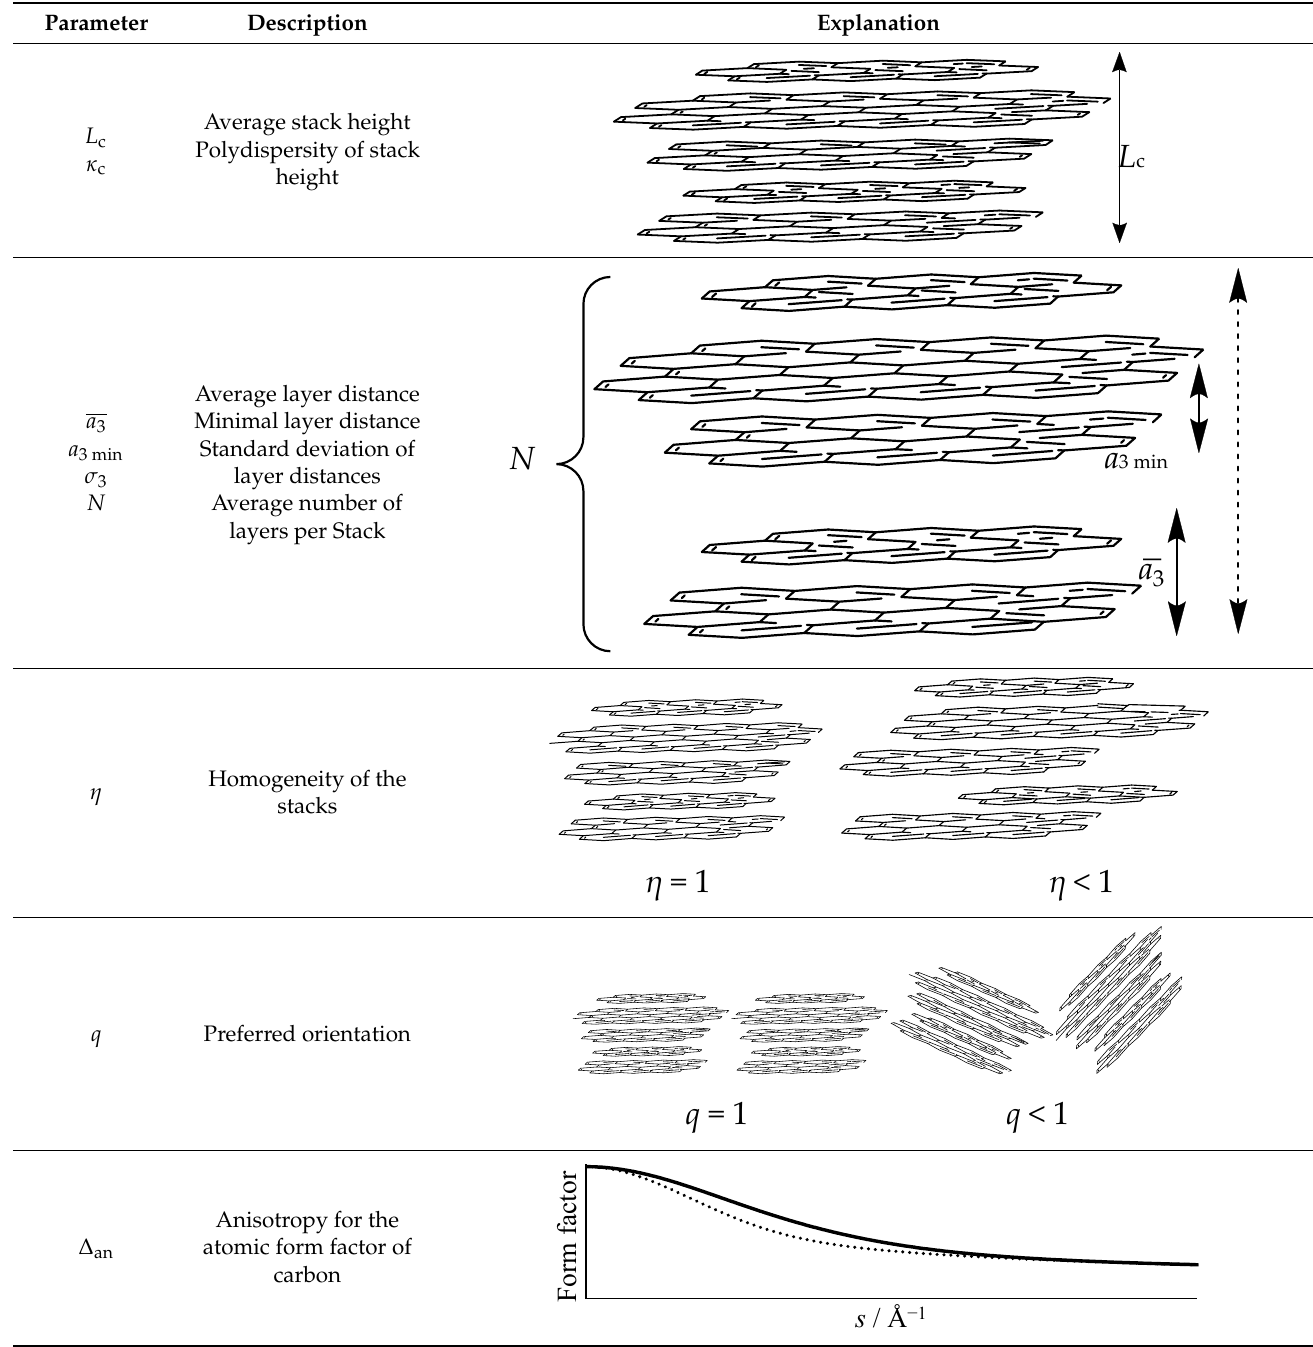
form factor of carbon ( ∆ an ) can be refined but have in most cases only a small influence on the analysis. The preferred orientation parameter ( q ) might also be refined, it also depends on the experimental setup, Table 2. Table 2. Microstructural parameters describing the graphene stacking (interlayer scattering I inter ). L c , κ c Table 2. Microstructural parameters describing the graphene stacking (interlayer scattering I inter ). Table 2. Microstructural parameters describing the graphene stacking (interlayer scattering I inter ). and N are mathematically dependent on each other and calculated from a gamma distribution n ( N ). N L c , κ c and N are mathematically dependent on each other and calculated from a gamma distribution Table 2. Microstructural parameters describing the graphene stacking (interlayer scattering I inter ). Table 2. Microstructural parameters describing the graphene stacking (interlayer scattering I inter ). Table 2. Microstructural parameters describing the graphene stacking (interlayer scattering I inter ). L c , κ c and N are mathematically dependent on each other and calculated from a gamma distribution n ( N ). N being the number of layers per stack, with the parameters μ and β [44] and is also dependent L c , κ c and N are mathematically dependent on each other and calculated from a gamma distribution being the number of layers per stack, with the parameters µ and β [44] and is also dependent on a 3 . L c , κ c and N are mathematically dependent on each other and calculated from a gamma distribution L c , κ c and N are mathematically dependent on each other and calculated from a gamma distribution n ( N ). N being the number of layers per stack, with the parameters μ and β [44] and is also dependent on a 3 (cid:3365) with N = L c / a 3 (cid:3365) . n ( N ). N being the number of layers per stack, with the parameters μ and β [44] and is also dependent n ( N ). N being the number of layers per stack, with the parameters μ and β [44] and is also dependent n ( N ). N being the number of layers per stack, with the parameters μ and β [44] and is also dependent on a 3 (cid:3365) with N = L c / a 3 (cid:3365) . on a 3 (cid:3365) with N = L c / a 3 (cid:3365) on a 3 (cid:3365) with N = L c / a 3 (cid:3365) .